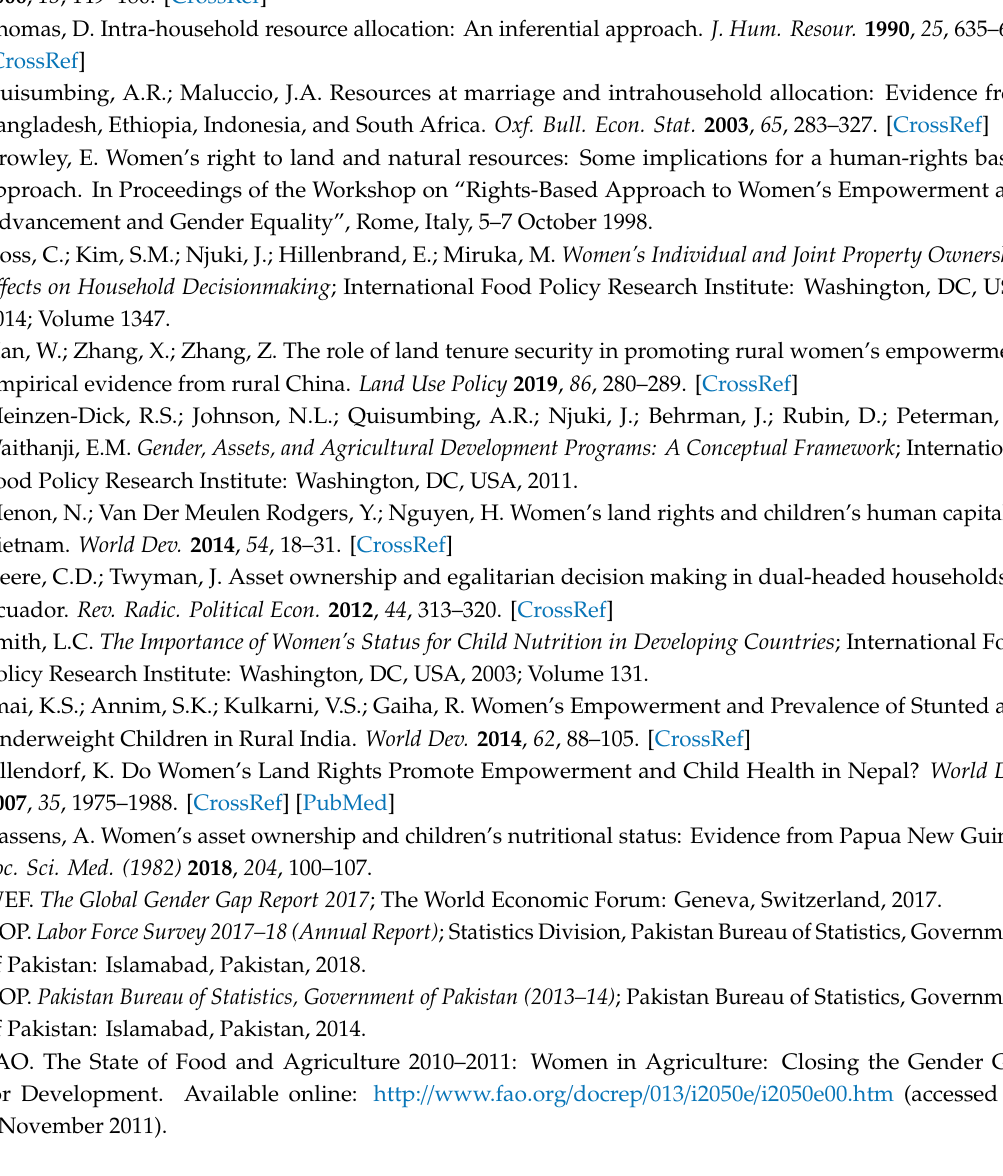
Table S1: Ordinary least squares estimates for child nutritional status of urban and rural regions, Table S2: Ordinary least squares estimates for child nutritional status in di ff erent